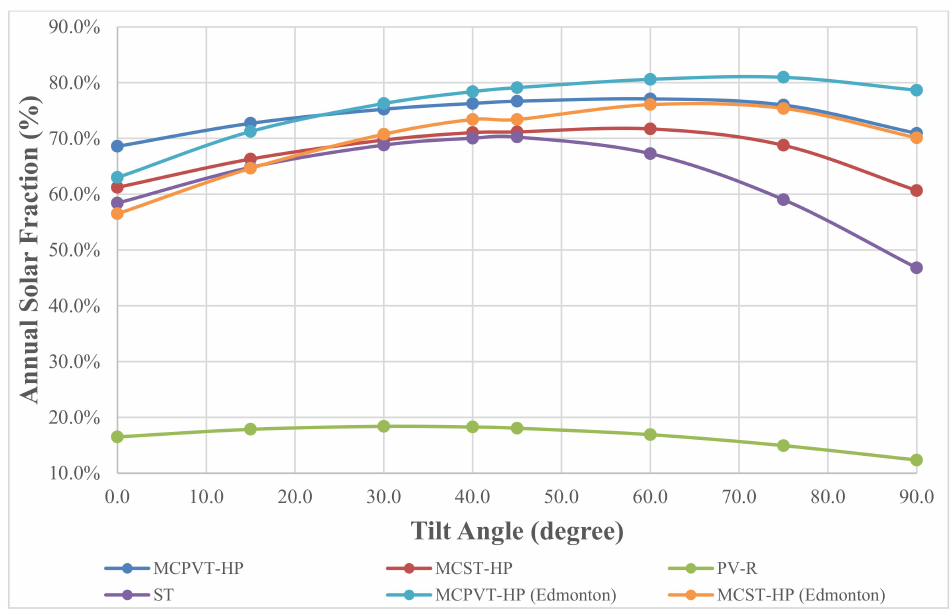
Figure 9. Impact of collector tilt angle on the overall system solar fraction for Toronto and Edmonton.